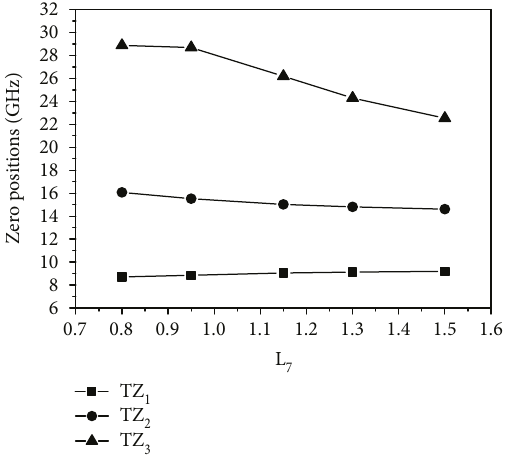
Figure 8: Three transmission zeros versus L